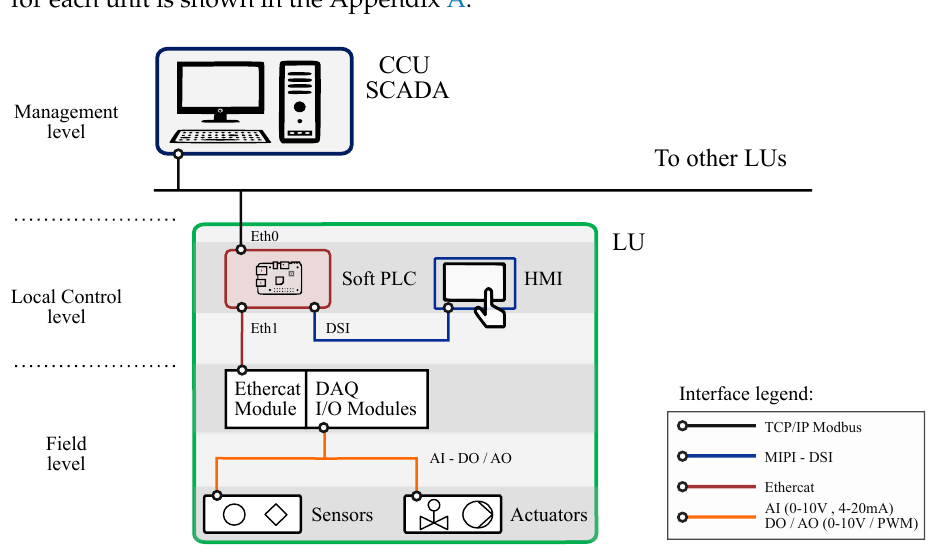
Figure 10. Scheme of the laboratory control and DAQ